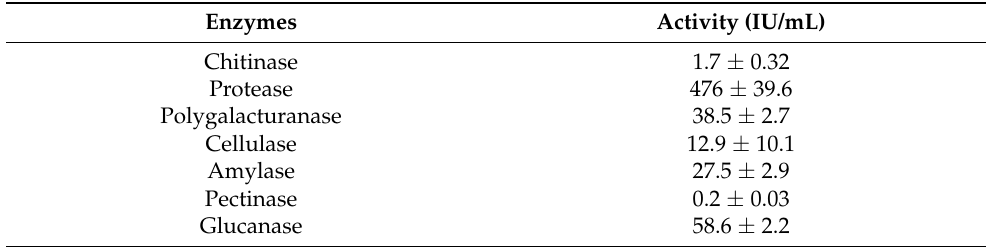
Table 3. Extracellular enzyme activities from T. hamatum